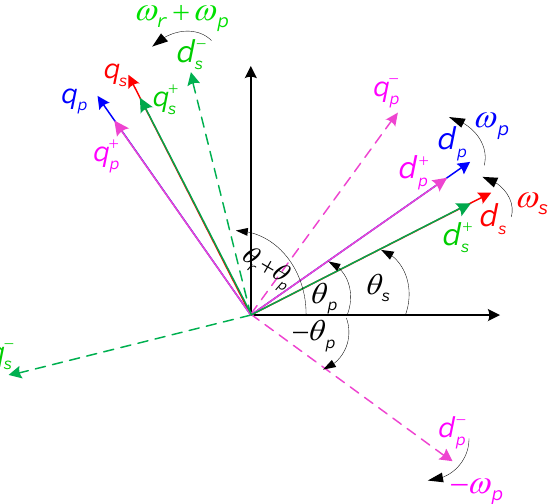
Figure 4. The reference frames used for the BDFRG model under unbalanced conditions.